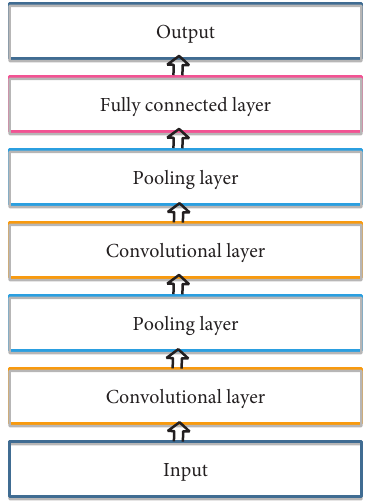
Figure 1: Typical architecture of a